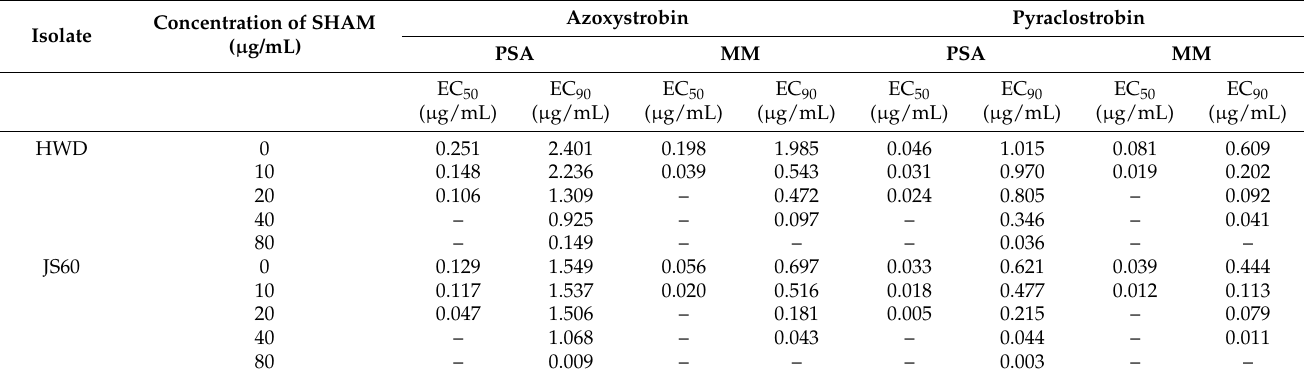
Table 3. Effects of SHAM at different concentrations on sensitivity of U. virens to azoxystrobin and pyraclostrobin.